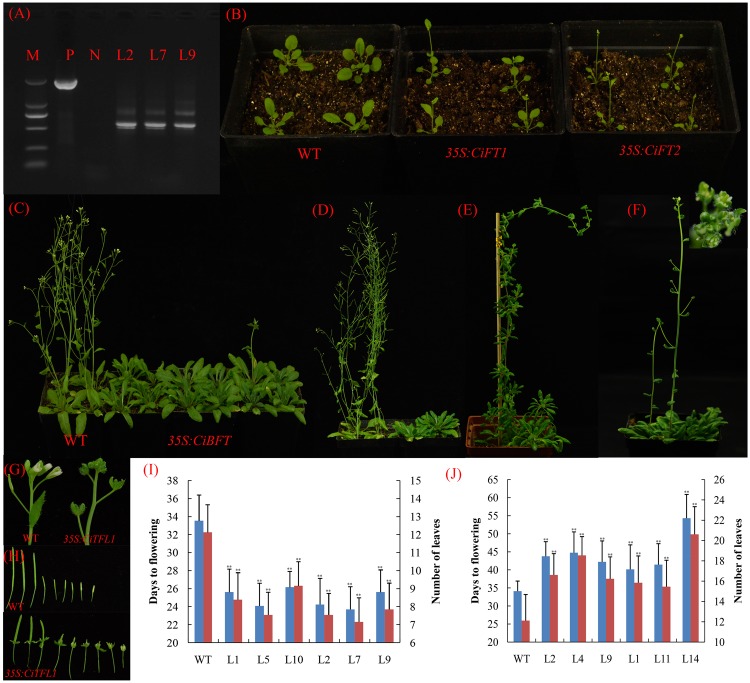
Phenotypes of 35S::CiFTα, 35S::CiFTβ, 35S::CiBFT, and 35S::CiTFL1 transgenic Arabidopsis. (A) RT-PCR analysis of the accumulation of CiFTβ in 35S::CiFTβ transgenic Arabidopsis RNA level. P: positive plasmid as a control, N: wild type Arabidopsis as a negative control, M: Marker 5000; L2, L7, and L9 are the 35S::CiFTβ transgenic lines. (B) Two randomly selected lines that constitutively expressed 35S::CiFTα and 35S::CiFTβ exhibited an early-flowering phenotype relative to wild-type controls under long days. (C) Ectopic expression of CiBFT in wild-type Arabidopsis delayed the flowering under long days. (D) Ectopic expression of CiTFL1 in wild-type Arabidopsis delayed flowering. (E) Two transgenic lines from 35S::CiTFL1 plants flowered significantly later than the wild-type plants. (F) Floral defects phenotype with conversion of sepals into leaf-like structures in some 35S:: CiTFL1 lines. (G) Severe phenotype with conversion of sepals into leaf-like structures in some 35S:: CiTFL1 lines. (H) Persistent sepals around the fruits in some 35S:: CiTFL1 lines. (I) Number of leaves and times to flowering of T3 plants of six independent transgenic lines from 35S::CiFTα (L1, L5, and L10) and 35S::CiFTβ (L2, L7, and L9). Blue bar indicates number of days to flowering, red bar indicated number of leaves to flowering. (J) Number of leaves and times to flowering of T3 plants of six independent transgenic lines from 35S::CiBFT (L2, L4, and L9) and 35S::CiTFL1 (L1, L11, and L14). Blue bar indicates number of days to flowering, red bar indicated number of leaves to flowering. The data were processed using ANOVA, and statistical differences were compared based on Student’s t-test, taking P < 0.01 as ∗∗.